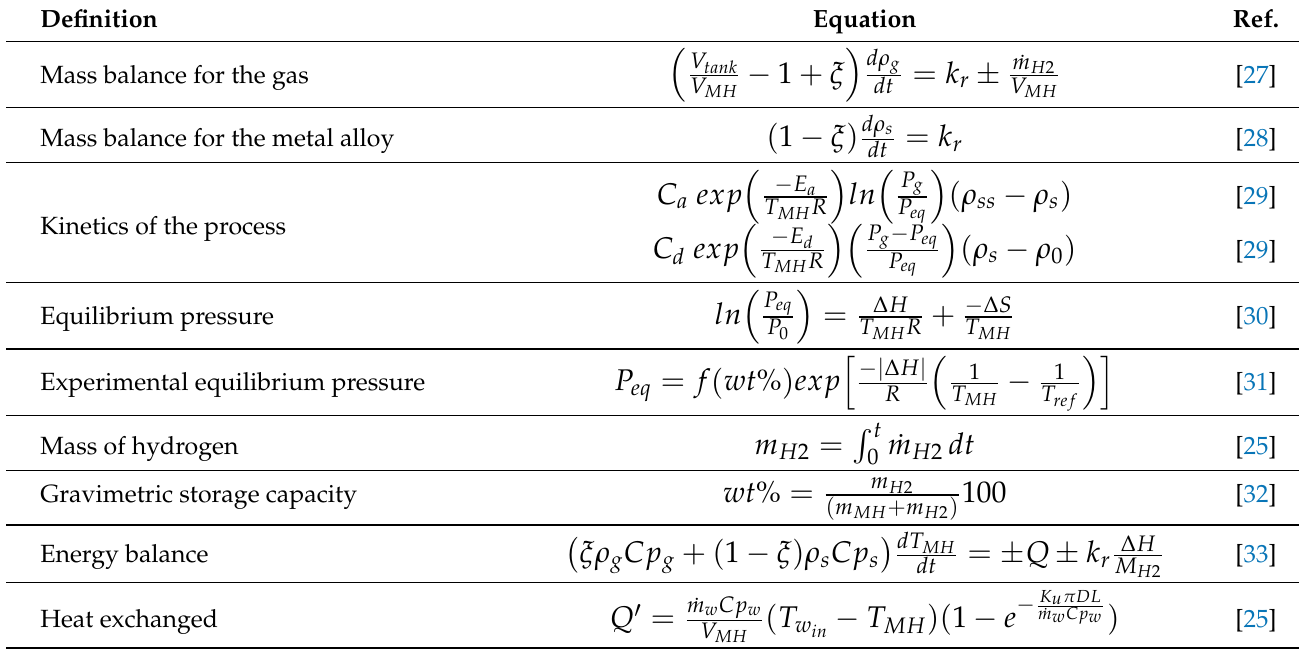
Table 1. Equations of the dynamic tank